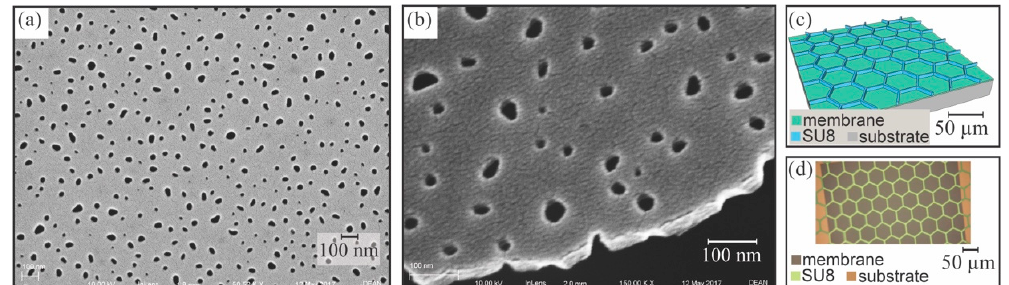
5 of 12 Figure 2. Sheet membrane fabrication process. ( a ) Assembled device halves ready for membrane